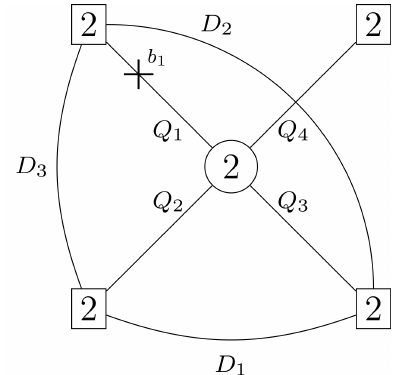
Figure 2 . Quiver diagram for the T 1